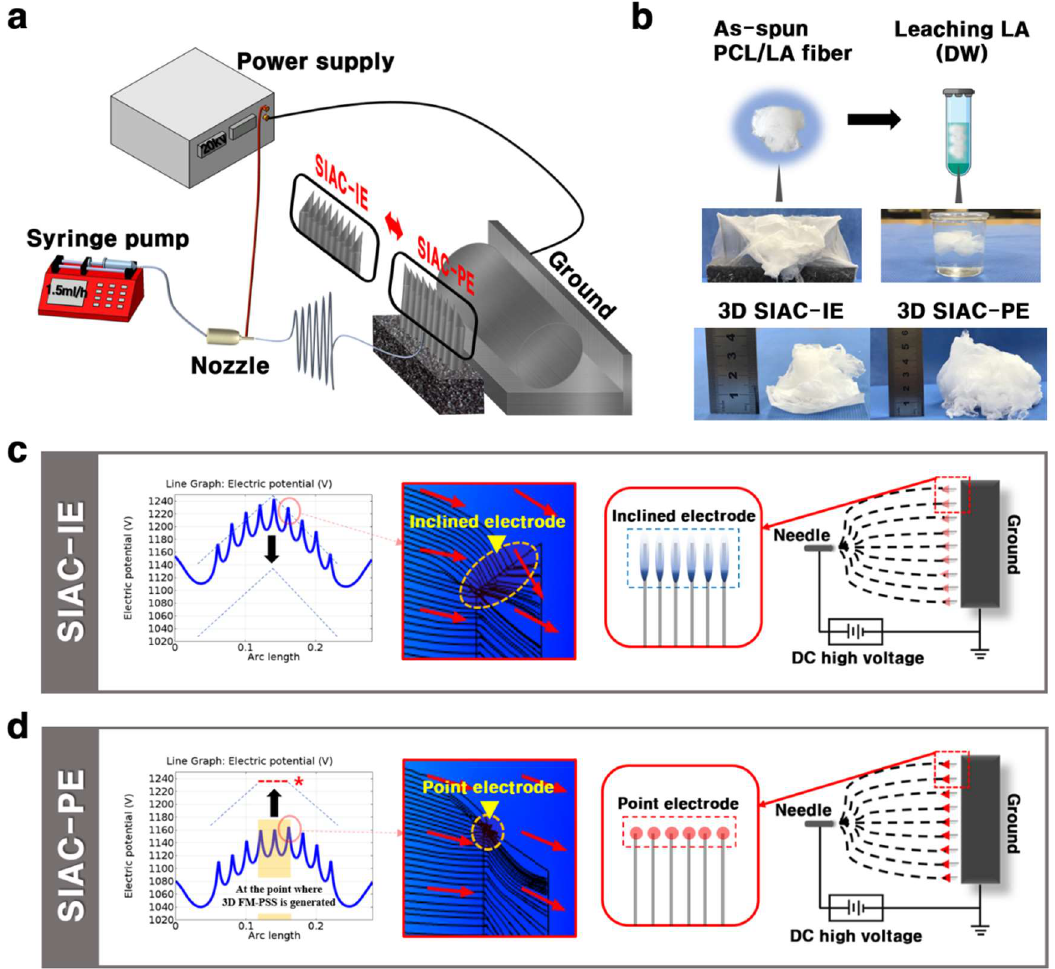
Figure 1. ( a ) Schematic illustration of electrospinning set up. ( b ) LA leaching process of PCL / LA fibers. Electric field analysis results of ( c ) SIAC-IE and ( d ) SIAC-PE.